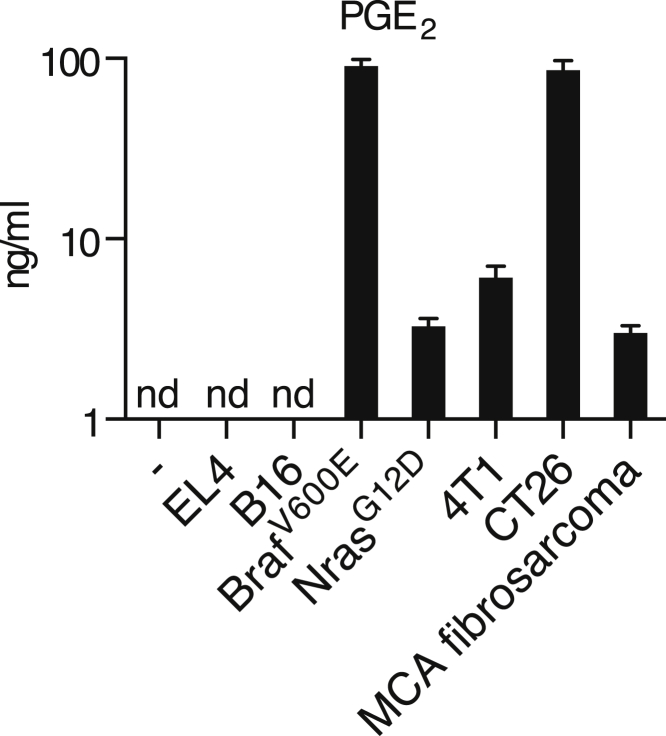
PGE2 Production by Cancer Cell Lines, Related to Figure 1EL4 thymoma, B16 melanoma, BrafV600E melanoma, NrasG12D melanoma, methylcholanthrene (MCA)-induced fibrosarcoma, 4T1 breast and CT26 colorectal cancer cell lines were cultured to confluency and the concentration of PGE2 in the supernatant was determined by ELISA. nd, not detected.